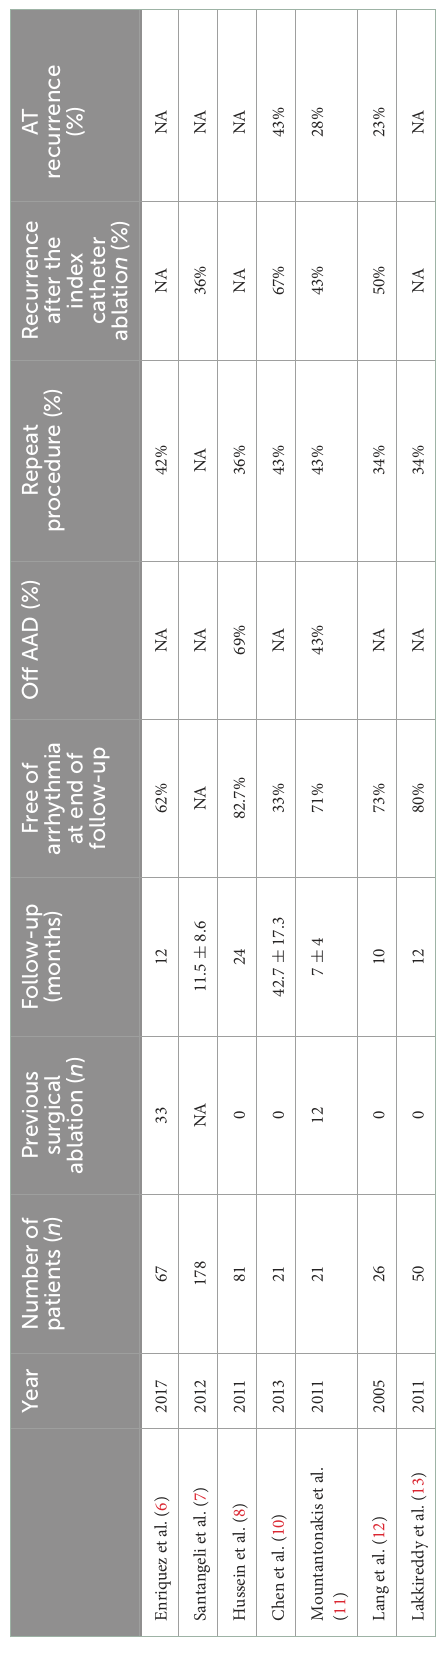
TABLE 3 Follow-up characteristics ( n =